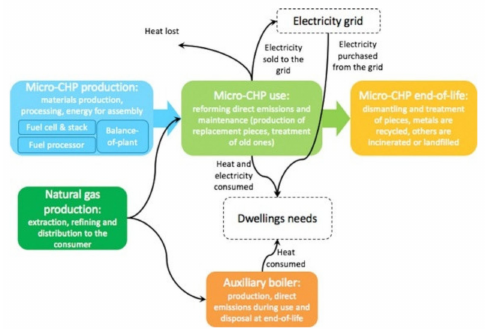
Figure 25. System boundaries considered for the LCA for the assessment of the steam reformer (SR) and autothermal reformer membrane reactor (ATR-MR) systems. Reprinted from [99], © 2020 with permission from